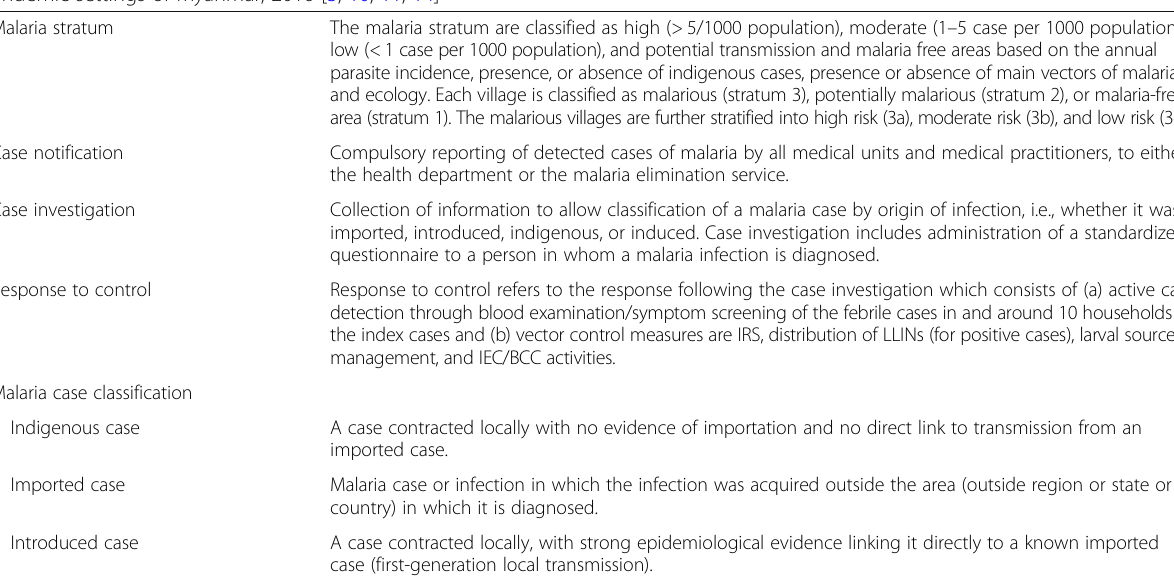
Table 1 Operational definitions for malaria case notification, investigation, classification, and response strategy implemented in low- endemic settings of Myanmar, 2016 [3, 10, 11,